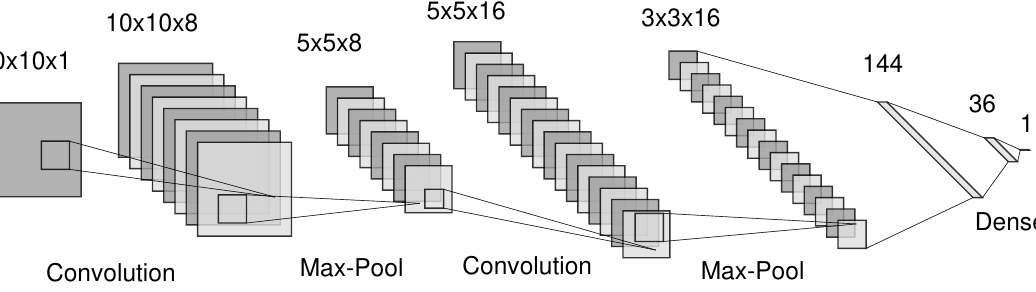
Figure 2 . Network architecture